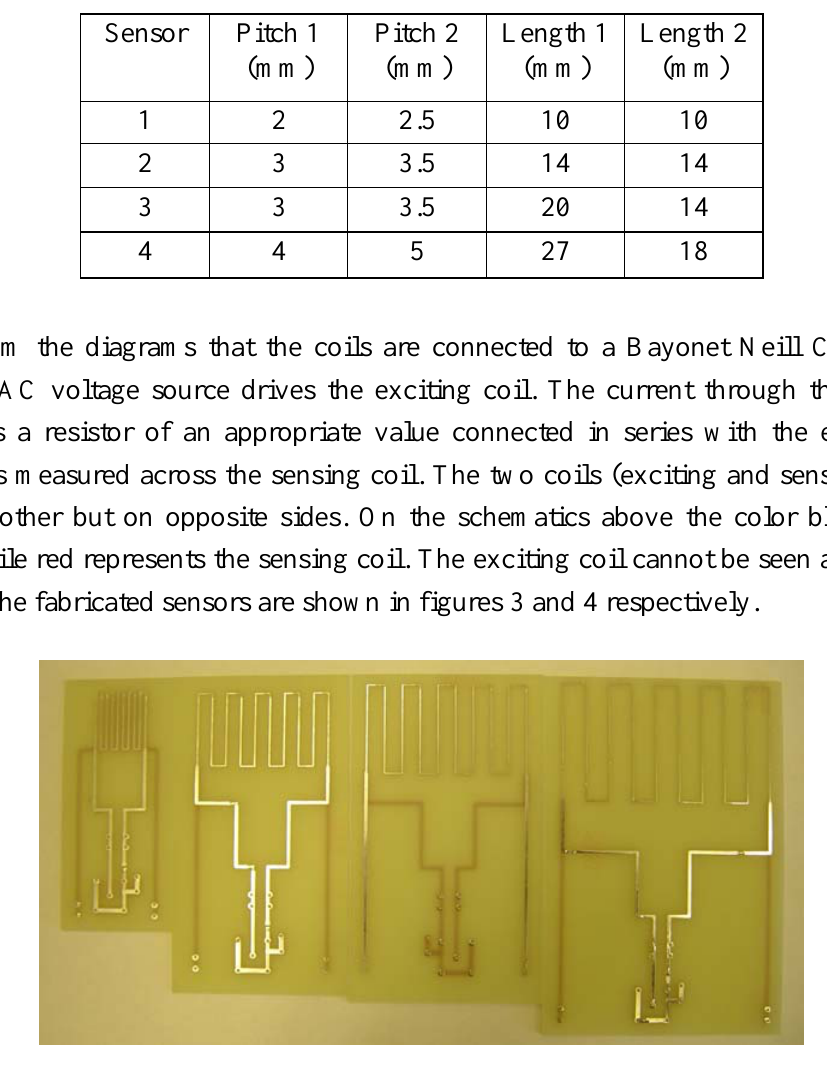
Figure 3. Fabricated meander type